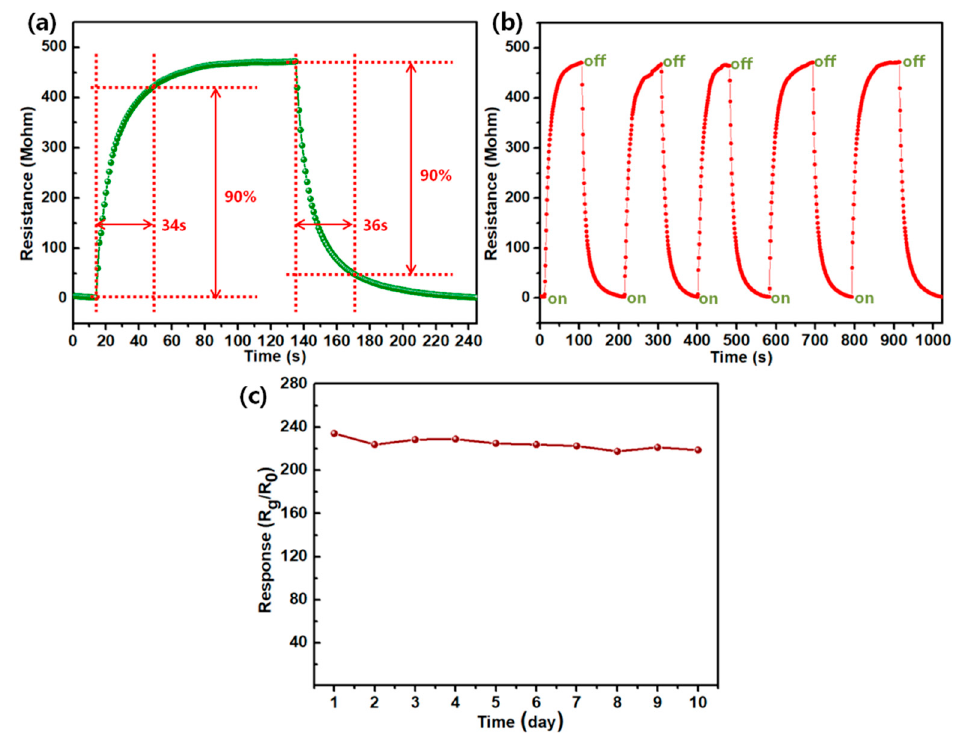
Figure 7. ( a ) The response and recovery of the ZnO/CQDs 1 eq composite to 100 ppm NO; ( b ) the repeatability of the ZnO/CQDs 1 eq composite at 100 °C to 100 ppm NO; ( c ) the long-term stability of the ZnO/CQDs 1 eq composite to 100 ppm NO.